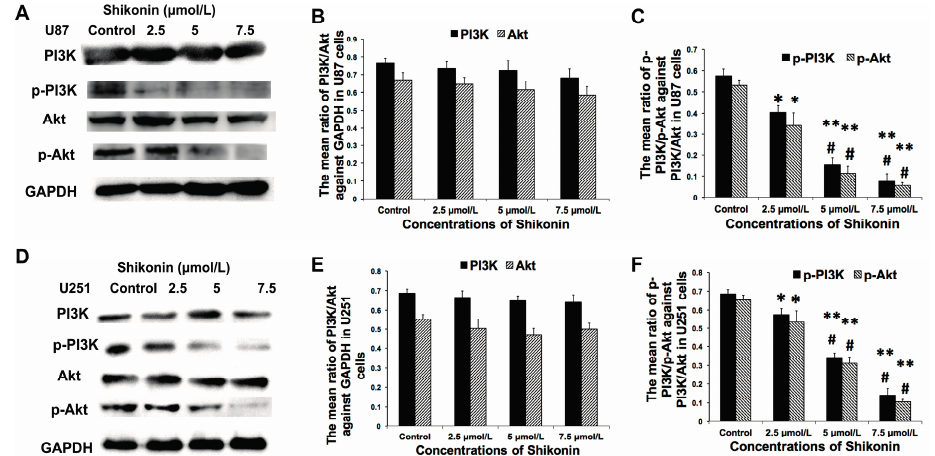
Figure 7. The effects of shikonin on the expression of p-Akt and p-PI3K in glioma cells. U87 and U251 cells were treated with shikonin at 2.5, 5, and 7.5 μ mol/L for 48h. The expression of p-PI3K and p-Akt was inhibited by the treatment of shikonin in a dose-dependent manner in both glioma cell lines. ( A ) Results of Western blot assay in U87 cells; ( B ) Statistical analysis of PI3K/Akt expression levels in U87 cells; ( C ) Statistical analysis of p-PI3K/p-Akt expression levels in U87 cells; ( D ) Results of Western blot assay in U251 cells; ( E ) Statistical analysis of PI3K/Akt expression levels in U251 cells; ( F ) Statistical analysis of p-PI3K/p-Akt expression levels in U251 cells. * p < 0.05, ** p < 0.01 compared with control; # p < 0.05 compared with the former concentration. ( n = 5).